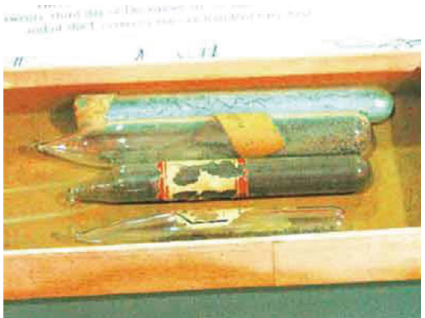
Figure 5. Three strains of Penicillium brought by Dr. Fan from the US to China in 1944 . These strains were critical for starting the production of penicillin in China. The strains are now on display at the Chinese Agricultural Museum in Nanjing Agricultural